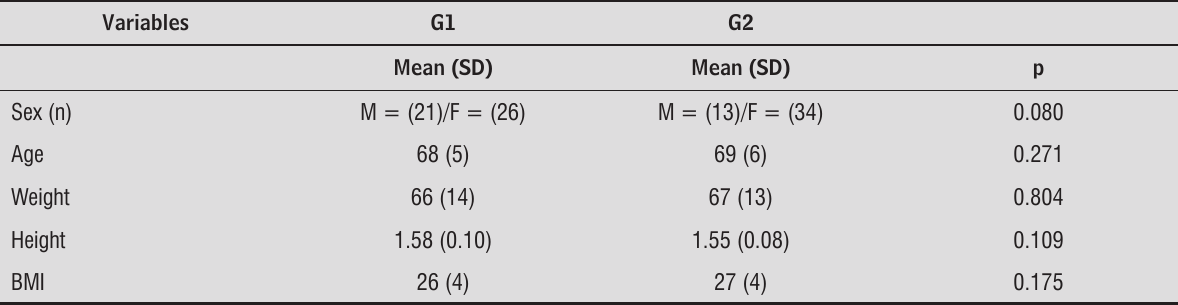
Table 1 - Distribution of gender, age and anthropometric characteristics (weight, height and body mass index) in the study groups (G1: without risk and G2: the risk of falls)